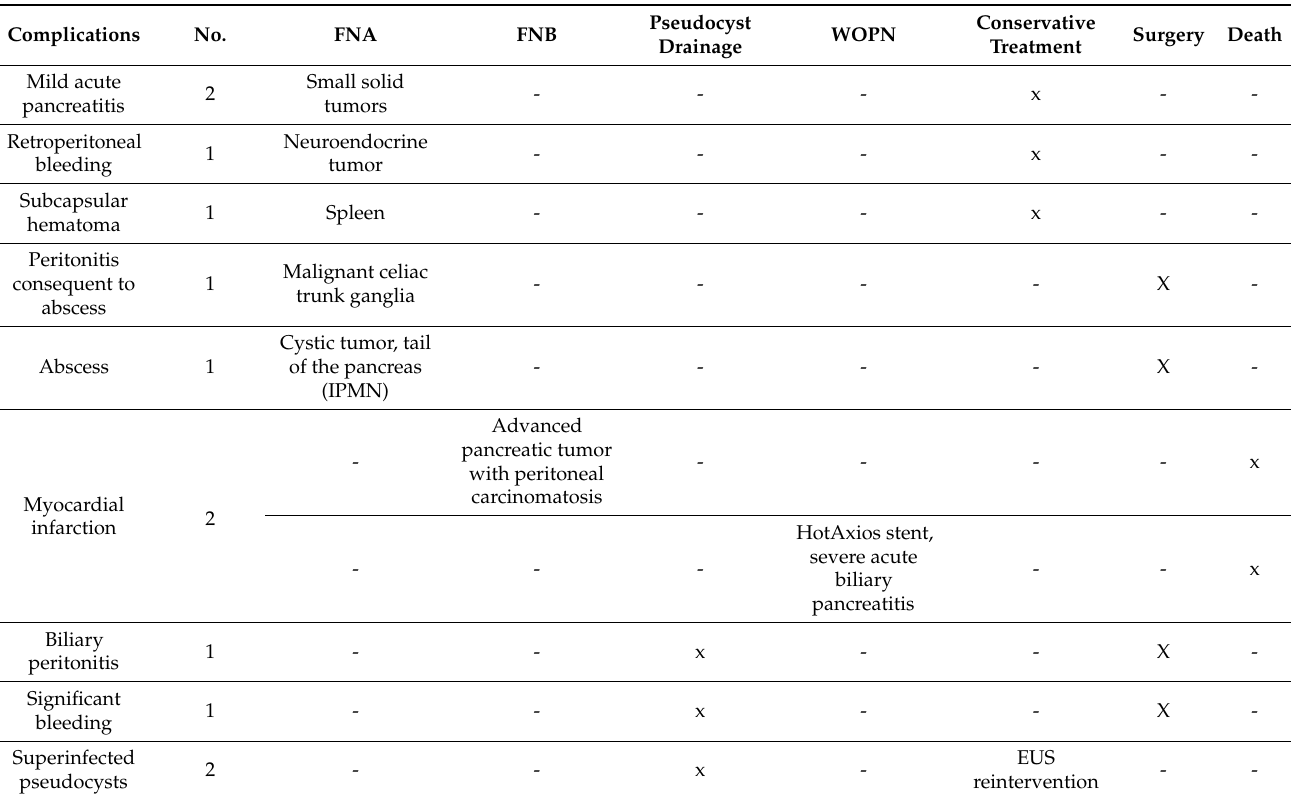
Table 4. Complications associated with the EUS procedures.